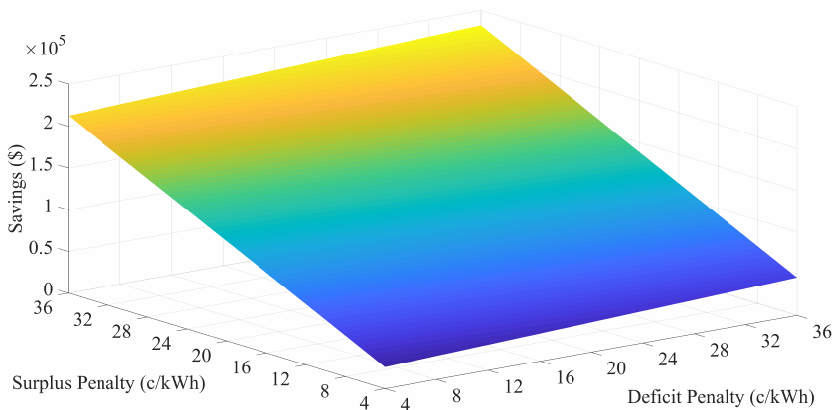
Figure 12. Monetary savings due to higher prediction accuracy for the 30-day period.